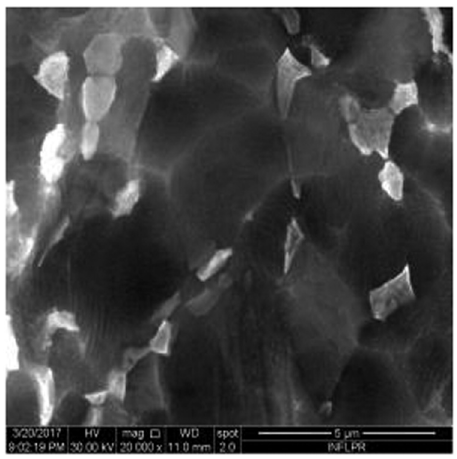
Figure 1: SEM image of sample S1 at a magni fi cation of 20k × .